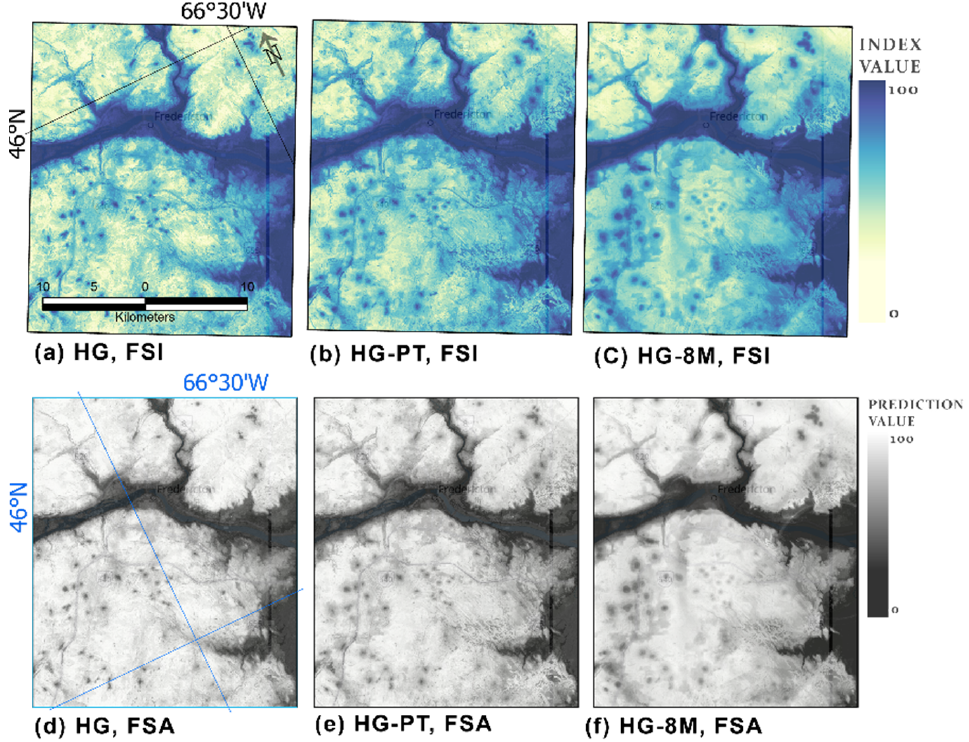
Figure 7. Index ( a – c ) and estimated accuracy of prediction ( d – f ) for the three tested variable groups in the NB study area.